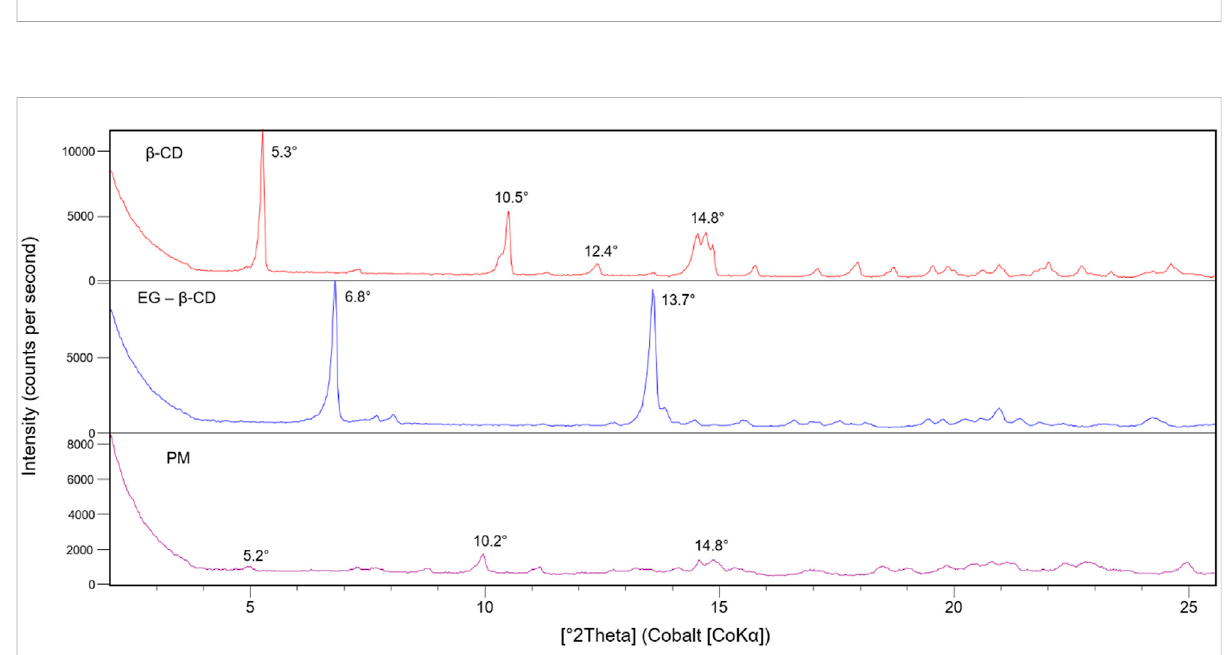
FIGURE 1 Diffractionpatternsoffree β -cyclodextrin( β -CD),inclusioncomplexofeugenol – β -cyclodextrinina1:1ratio,inclusioncomplexofeugenol – β - cyclodextrin in a 2:1 ratio, inclusion complex of eugenol – β -cyclodextrin in a 2:3 ratio, and physical mixture (PM) were analyzed using the diffractograms.